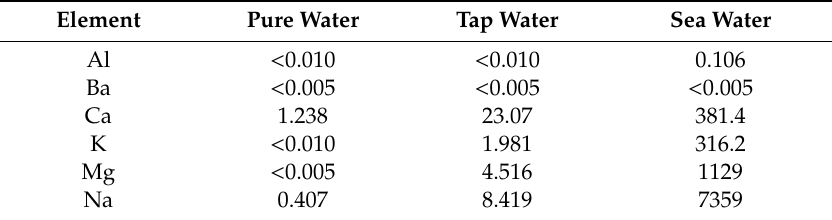
Table 3. Cations concentration (ppm) of pure water, tap water, and sea water.